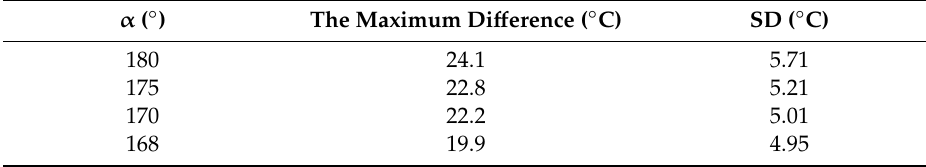
Table1. Thestandarddeviation(SD)andthemaximumtemperaturedi ff